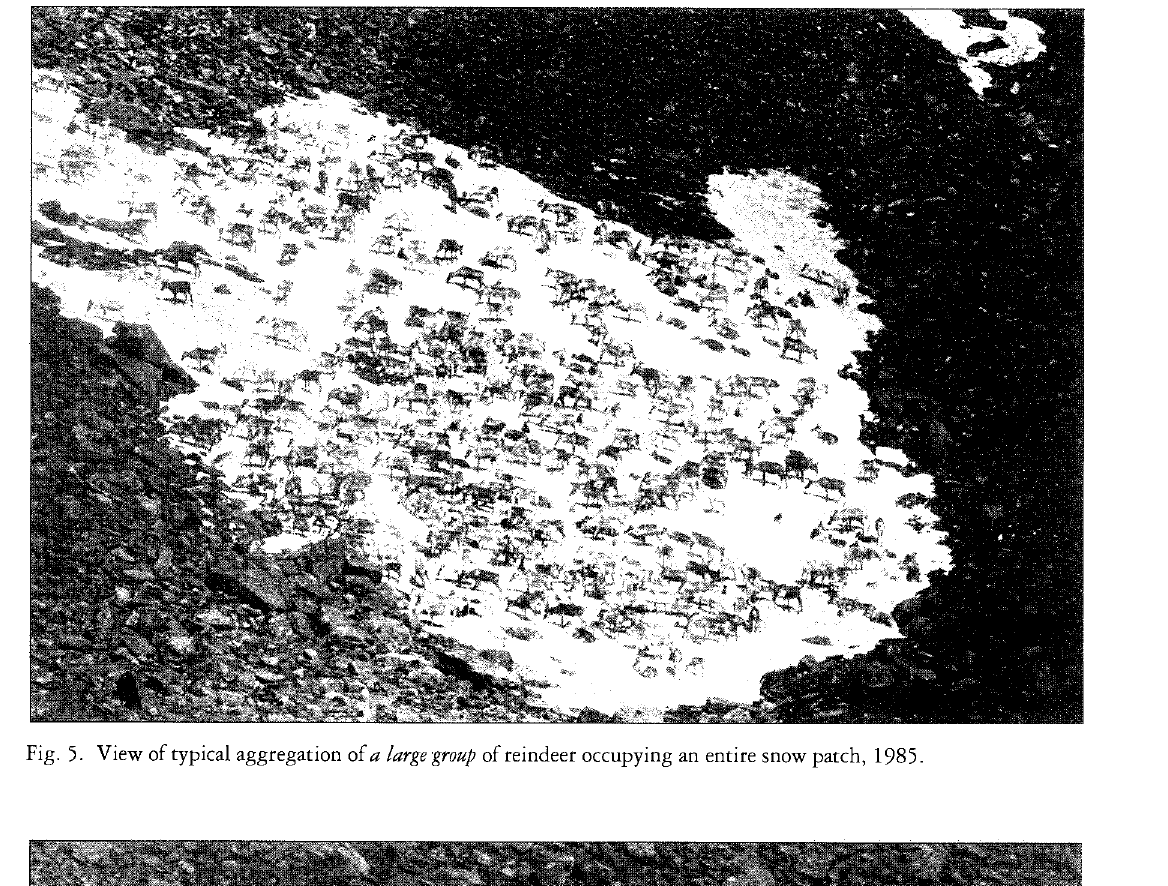
Fig. 5. View of typical aggregation of a large group of reindeer occupying an entire snow patch,